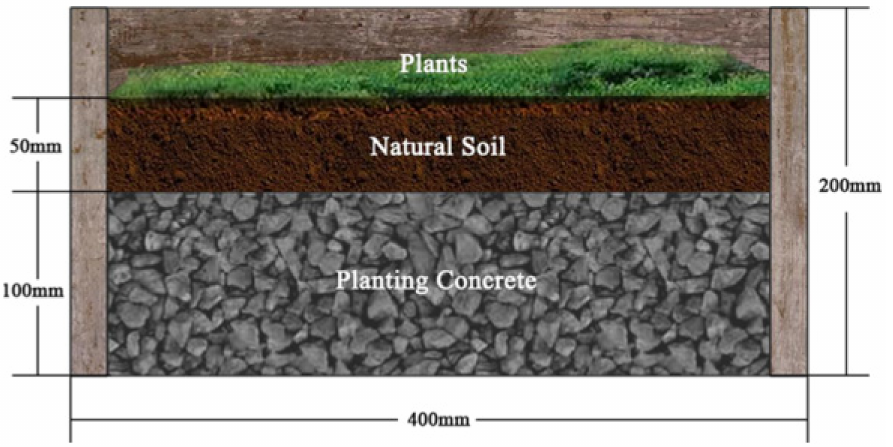
Figure 2. Sketch of the planting concrete sample used for the vegetation